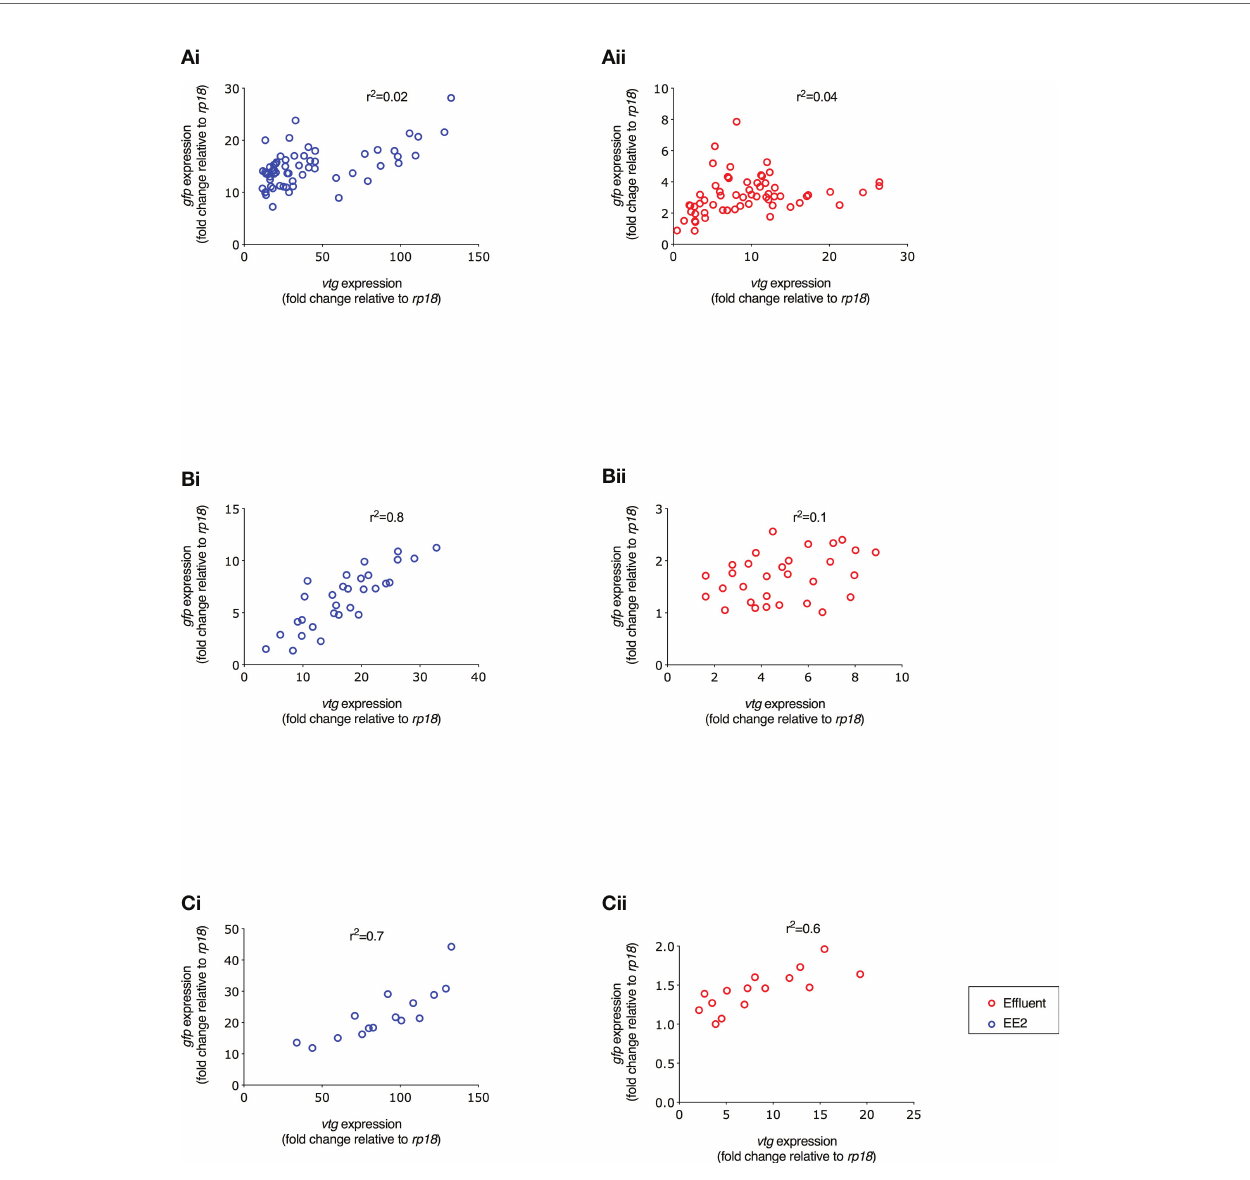
FIGURE 6 | Correlation between gfp and vtg mRNA expression in ERE-GFP Casper zebra fi sh for different life stage exposure periods. Transgenic zebra fi sh were exposed to (i) EE2 (10 ng/L) or (ii) a graded ef fl uent (50% and 100%) during the following developmental periods: (A) 0-90 days, (B) 21-60 days, and (C) 60-90 day. Data are reported as mean ± SE and expressed as fold-change compared with the control. Relative mRNA expression was determined as the ratio of target gene mRNA/ rpl8